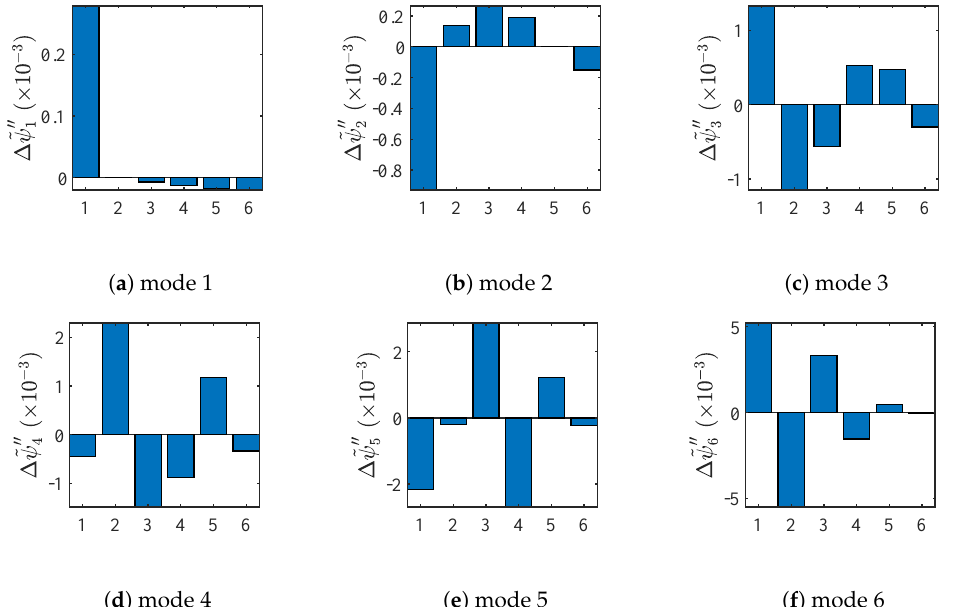
Figure 24. Shear frame: theoretical MSCs differences under 1% damage in K 1 , during a long time-scale instant from the validation